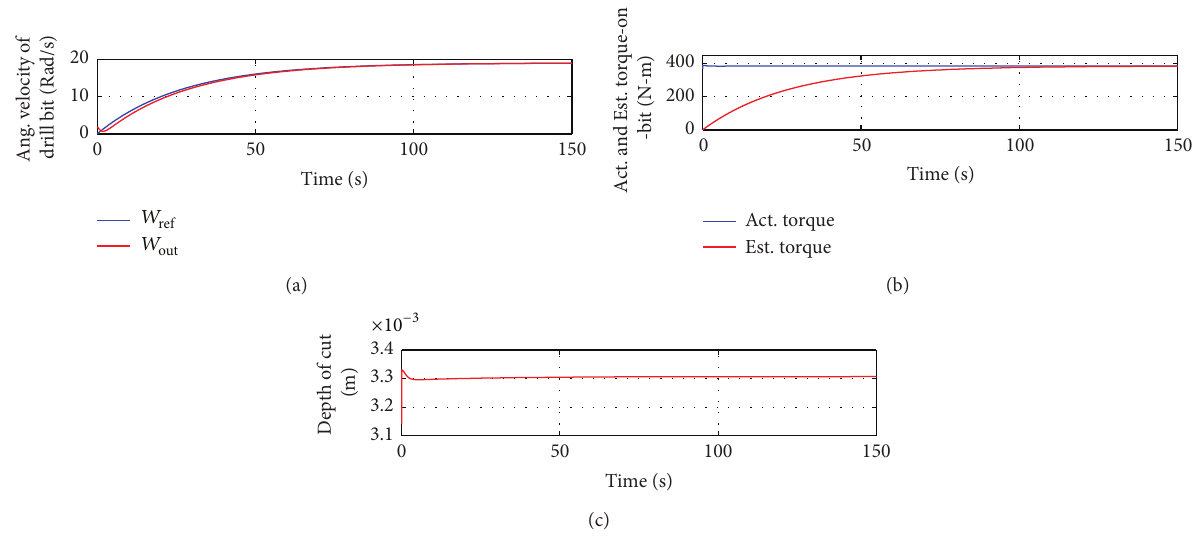
̂𝑇(𝑡) (b), and the depth of cut 𝑑(𝑡) (c)